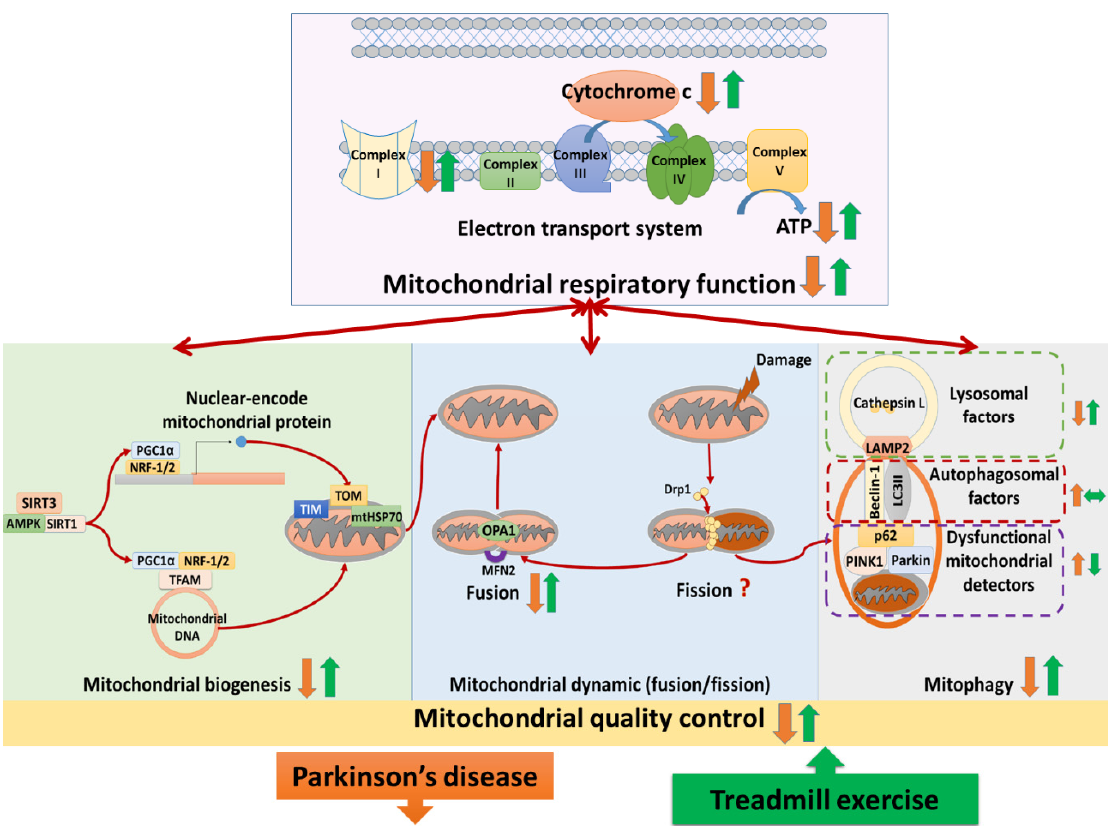
Figure 2. The hypothesized figure. The figure shows the structure of the electron transport system and the cycle of mito- chondrial quality-control. The electron transport system includes complexes I–V and cytochrome c , taking the primary responsibility for producing ATP (adenosine triphosphate) in neurons. Neural mitochondrial quality-control is the